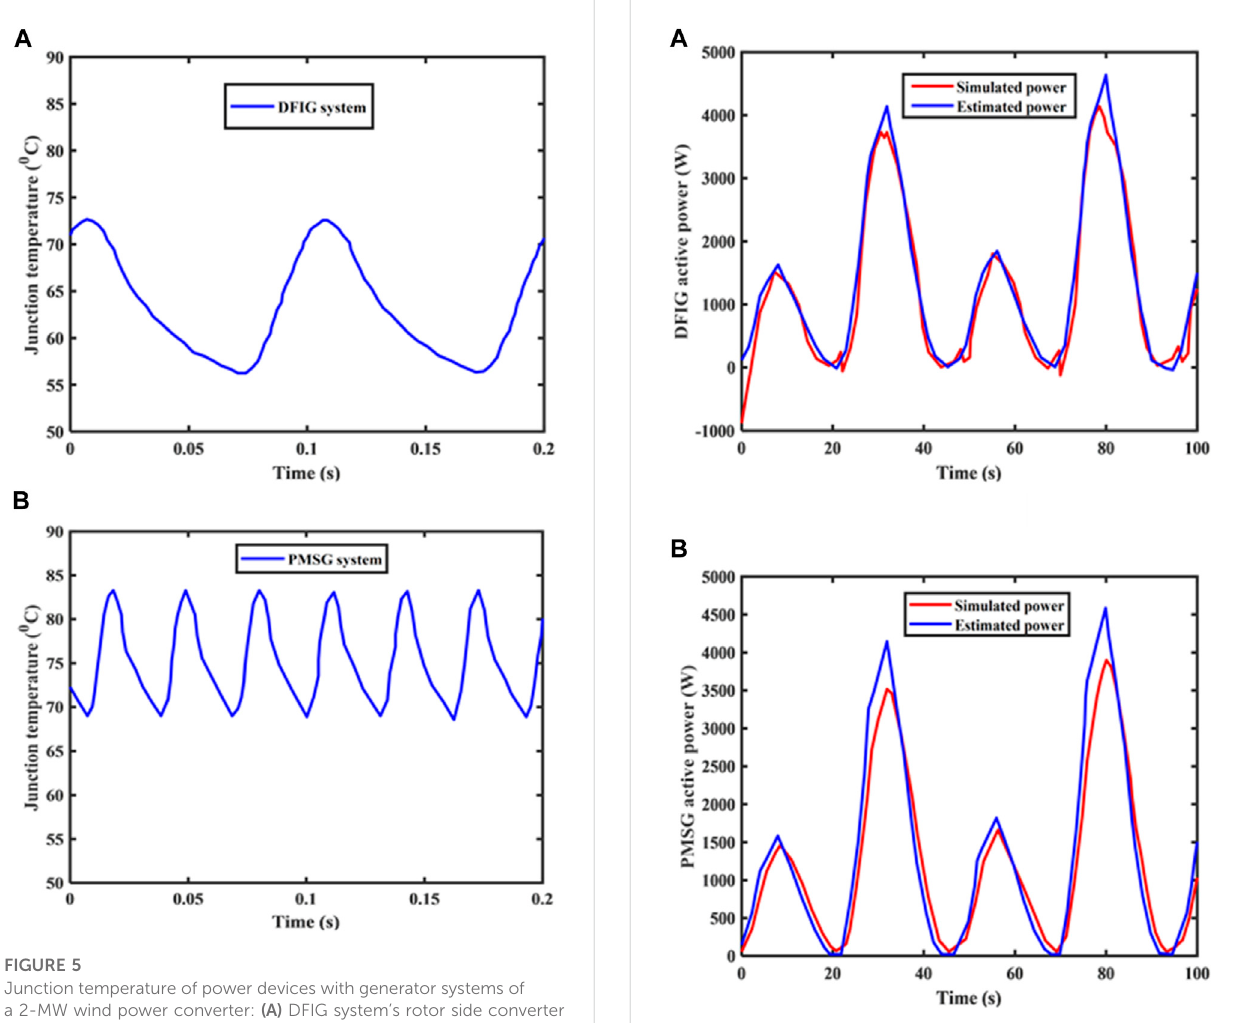
Active power performances of (A) DFIG-based wind energy harvesting technology and (B) PMSG-based wind energy harvesting technology (Benelghali et al.,